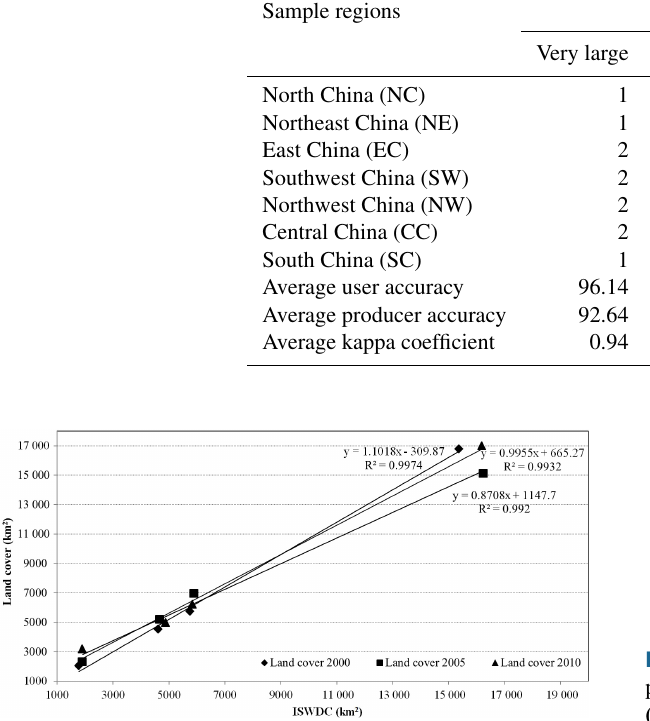
Figure 3. Comparison of the total areas of surface water body sam- ples with different size ( < 100, 100–500, 500–1000, > 1000km 2 ) between ISWDC and the national land-cover-derived surface water data.